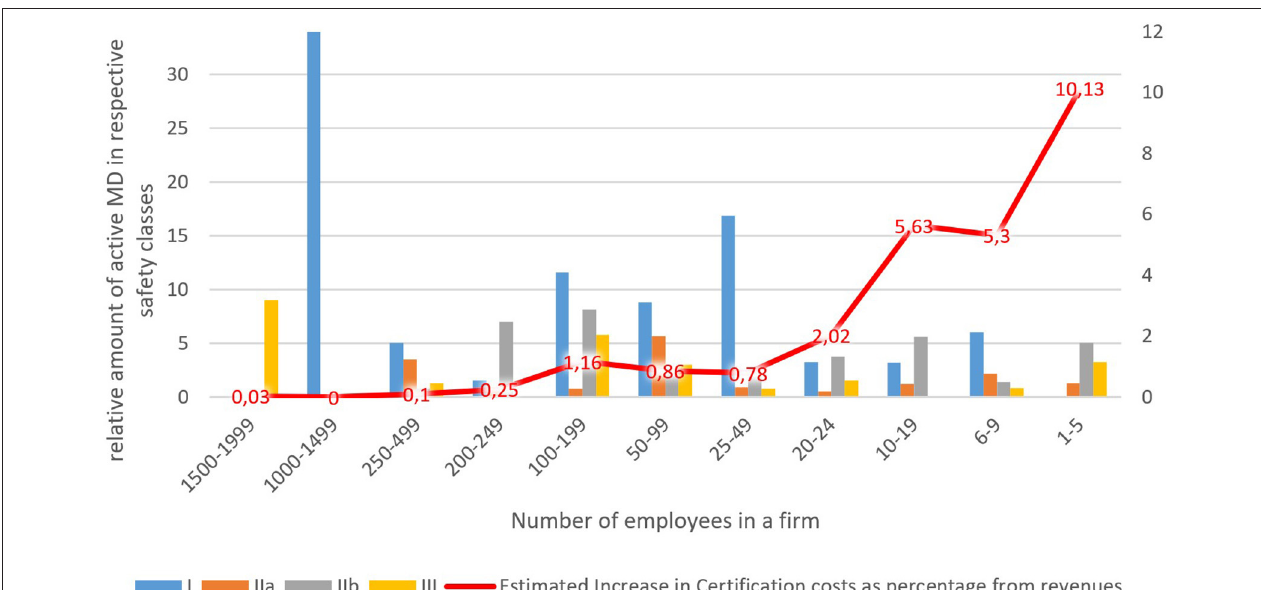
FIGURE 1 | Certification